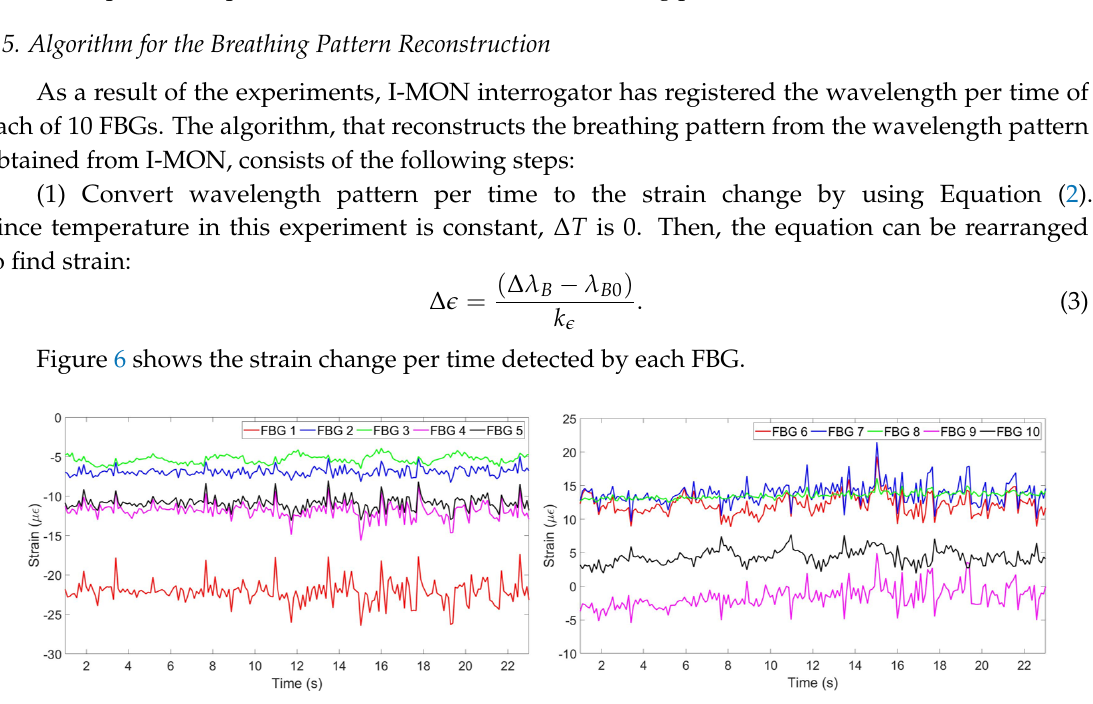
Figure 6. Strain pattern detected by 5 FBGs on the chest ( left ) and by 5 FBGs on the abdomen ( right